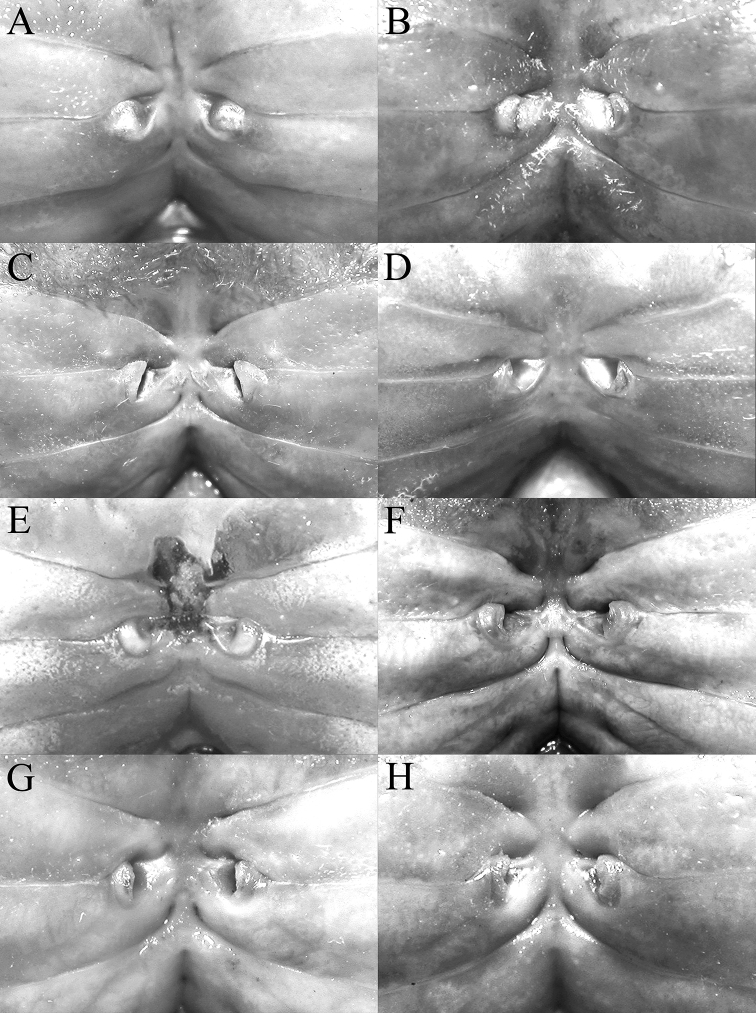
Sternopleonal cavity and vulvae AJohora
intermedia Ng, 1986, female (17.9 × 14.7 mm) (ZRC 2001.1002), Selangor BJ.
tahanensis (Bott, 1966), female (24.4 × 21.0 mm) (ZRC 1984.6765), Pahang CJ.
thoi Ng, 1990, female (31.7 × 25.5 mm) (ZRC 2001.1167), Terengganu DJ.
hoiseni Ng & Takeda, 1992, paratype female (22.1 × 19.0 mm) (ZRC 1984.6675), Kelantan EJ.
thaiana Leelawathanagoon, Lheknim & Ng, 2005, paratype female (21.0 × 17.4 mm) (ZRC 2006.0053), Thailand FJ.
booliati sp. nov., paratype female (40.4 × 34.4 mm) (ZRC 1995.270), Pahang GJ.
erici sp. nov., paratype female (32.8 × 26.9 mm) (ZRC 1995.268), Perak HJ.
michaeli sp. nov., paratype female (29.9 × 25.0 mm) (ZRC 2010.0047), Terengganu.